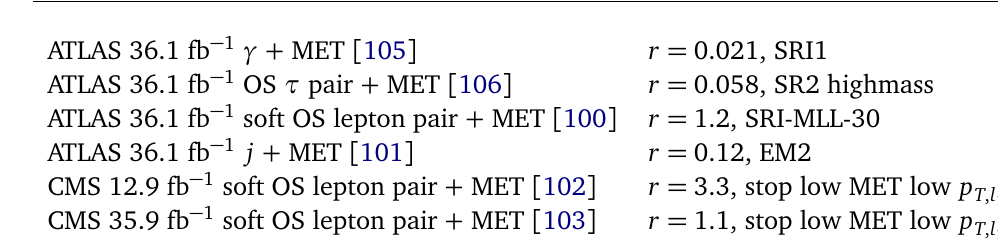
Table 6: Summary of constraints on benchmark point [ 4 ] from the most sensitive 13 TeV searches implemented in C HECK MATE at the LHC. The two last results where a similar analysis with less data is more sensitive can be explained by differences in the base selection criteria. All the signal regions shown here require at least / E (cid:166) 100 GeV. The SRI1 signal region selects events with no more than two jets T and a hard photon. The SR2 highmass region is designed for events with two hard taus, with large invariant mass and m . SRI-MLL-30 is inclusive in lepton flavor T 2 and select lepton pairs with invariant mass m (cid:96)(cid:96) ∈ [ 1,30 ] GeV. EM2 simply requires / E ∈ [ 300,350 ] GeV. Finally, the last region targets relatively compressed spectra T and cuts on the leading lepton p . T